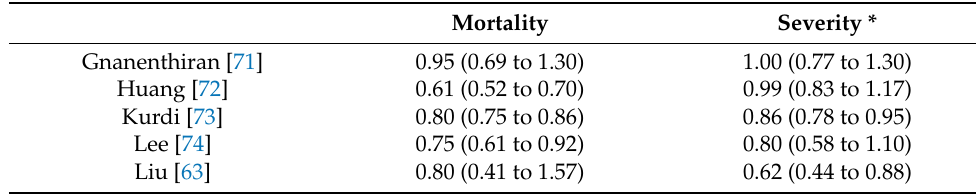
Table 3. Odds ratio (95% confidence interval) of the effects of ACEIs and ARBs on COVID-19 outcomes.